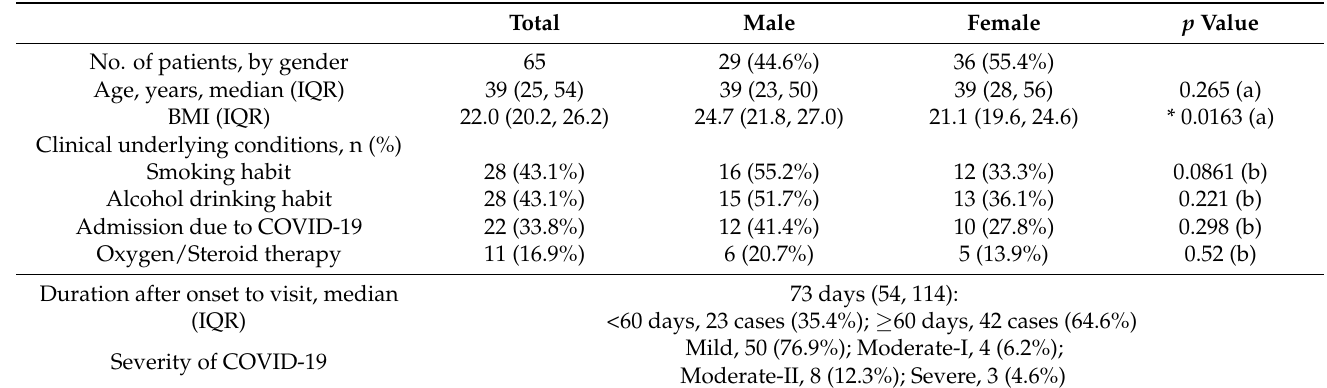
Table 1. Backgrounds of patients visiting the COVID-19 aftercare outpatient clinic ( n = 65). IQR, interquartile range; the data were analyzed by (a) by Mann-Whitney U or (b) Fisher’s exact tests; and * p < 0.05, statistically